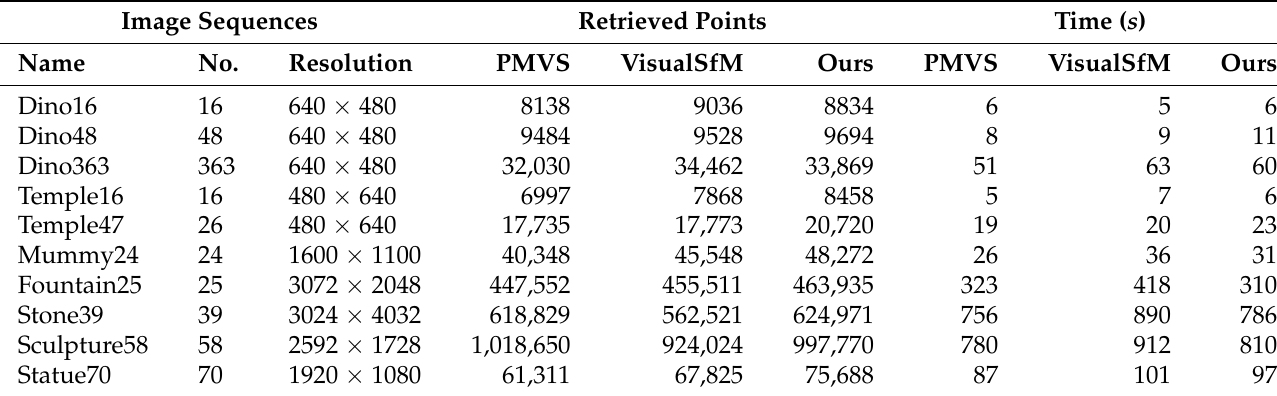
Table 2. Comparison of retrieved points and running time of three